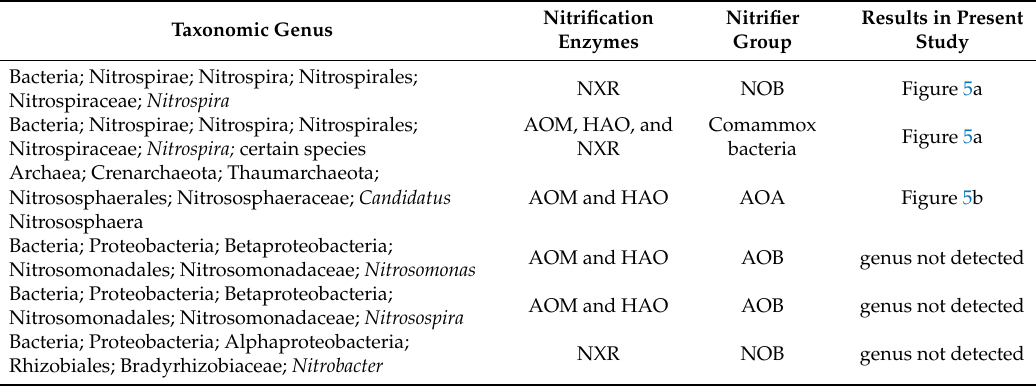
Table 2. The microbial groups with nitrification functions identified from previous summary [3].